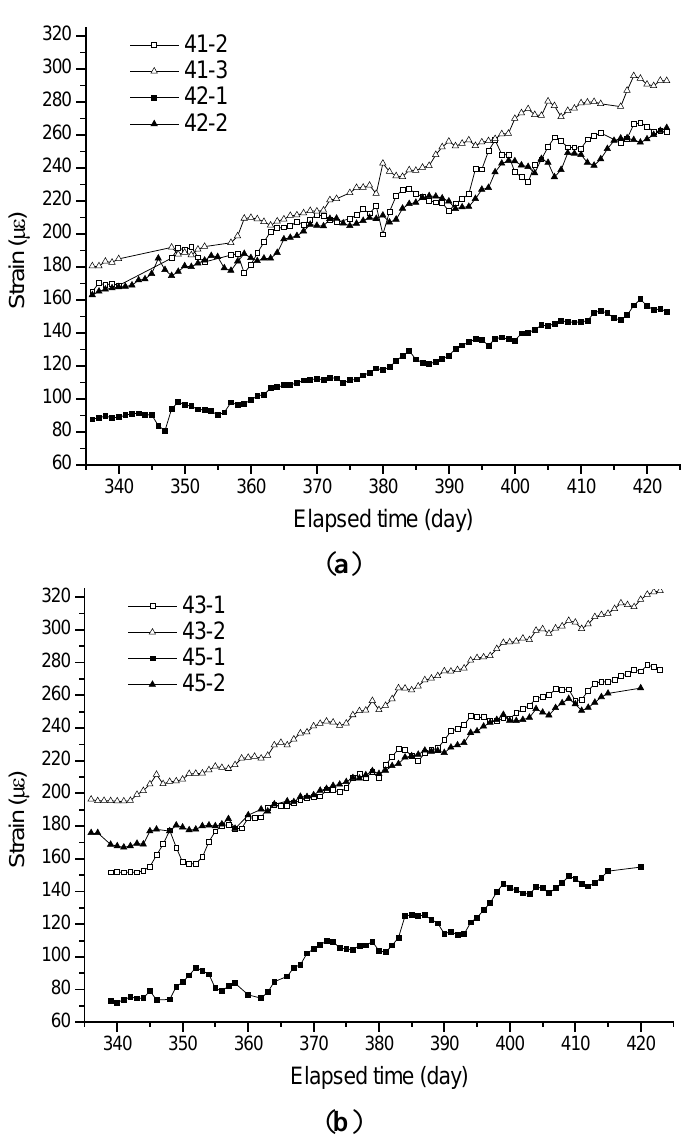
Figure 11. History of strains measured from sensors at the 10th floor of towers 1 and